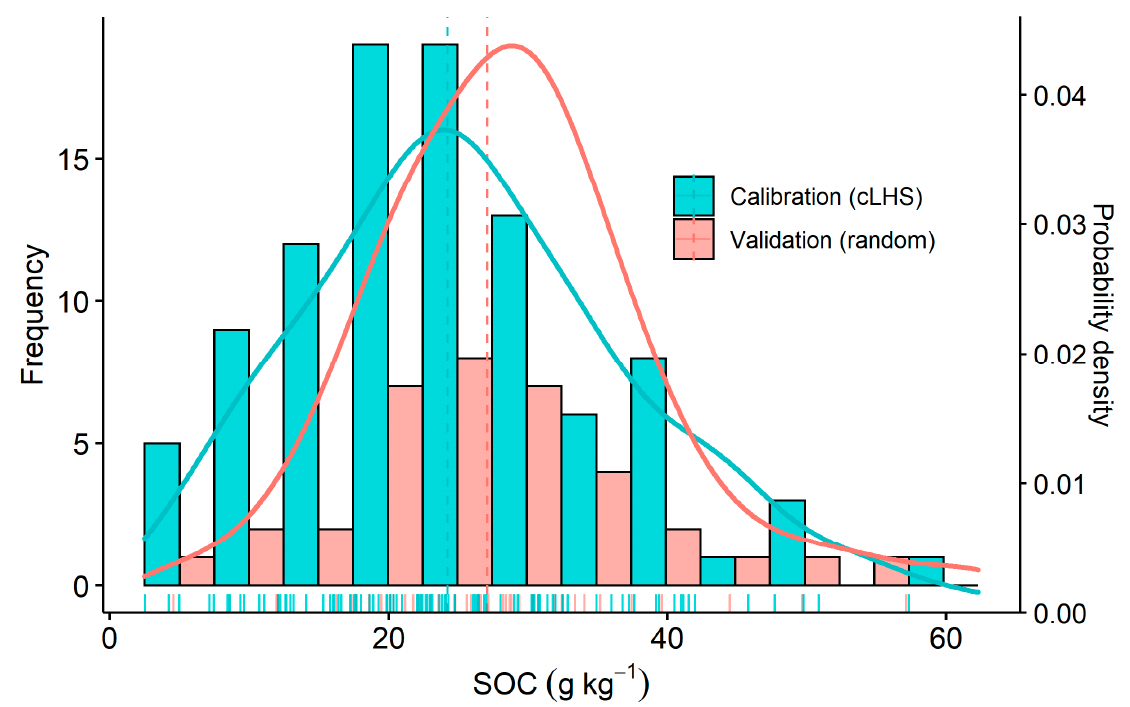
Figure 3. Soil organic carbon (SOC) content distribution in the calibration and validation datasets as represented by the histogram, density plot, and rug plot. Vertical dashed lines represent the mean values.